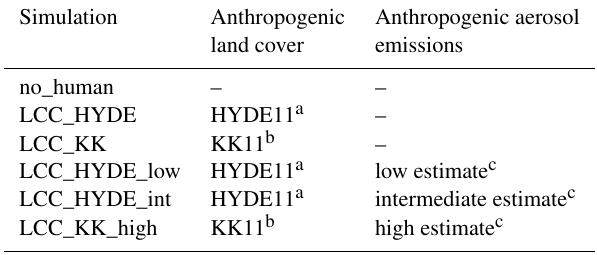
Table 4. Overview of the different simulations. Note that the anthropogenic land cover change is applied in ECHAM-HAM- SALSA but not in CBALONE–SPITFIRE, which was used to cal- culate aerosol emissions from natural fires